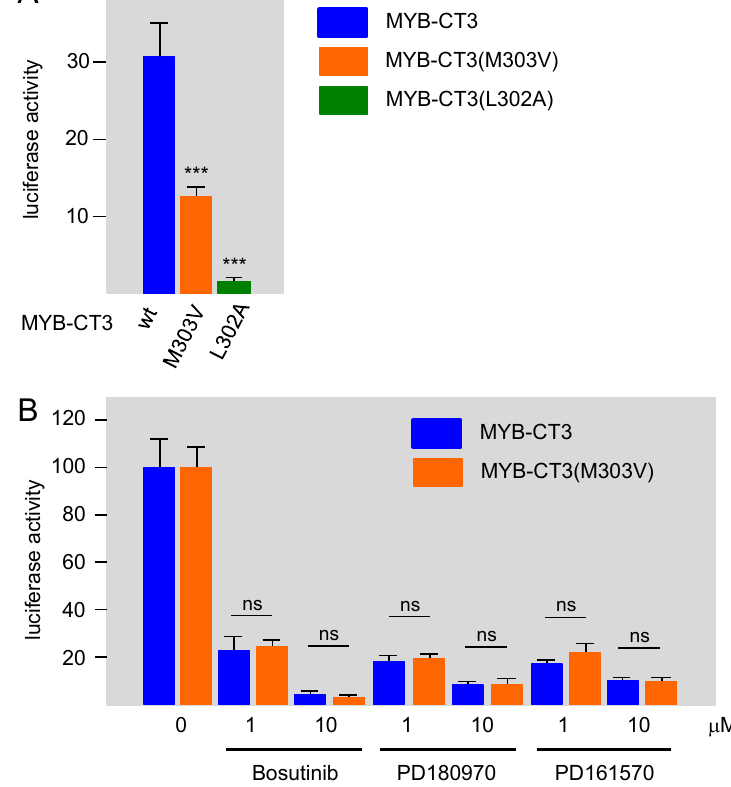
Figure 5. Bosutinib, PD161570, and PD180970 disturb the cooperation between MYB and co-activator p300. ( A ) Luciferase reporter assays of HEK293T cells transfected with the MYB-responsive reporter gene pGL4 ‐ 5xMRE(GG) ‐ Myc and expression vectors for MYB ‐ CT3, MYB ‐ CT3(M303V), or MYB ‐ CT3(L302A). Asterisks indicate statistical significance (*** p < 0.001; Student’s t ‐ test). ( B ) HEK293T cells were transfected with reporter gene pGL4 ‐ 5xMRE(GG) ‐ Myc and expression vectors for MYB ‐ CT3 or MYB ‐ CT3(M303V) and treated without or with the indicated concentrations of the kinase inhibitors for 16 h before harvesting and measuring luciferase activities. To compensate for the difference in activity between MYB ‐ CT3 and the M303V mutant, luciferase activities of untreated cells were normalized to 100 percent. “ns” refers to “not statistically significant” (Student’s t ‐ test).